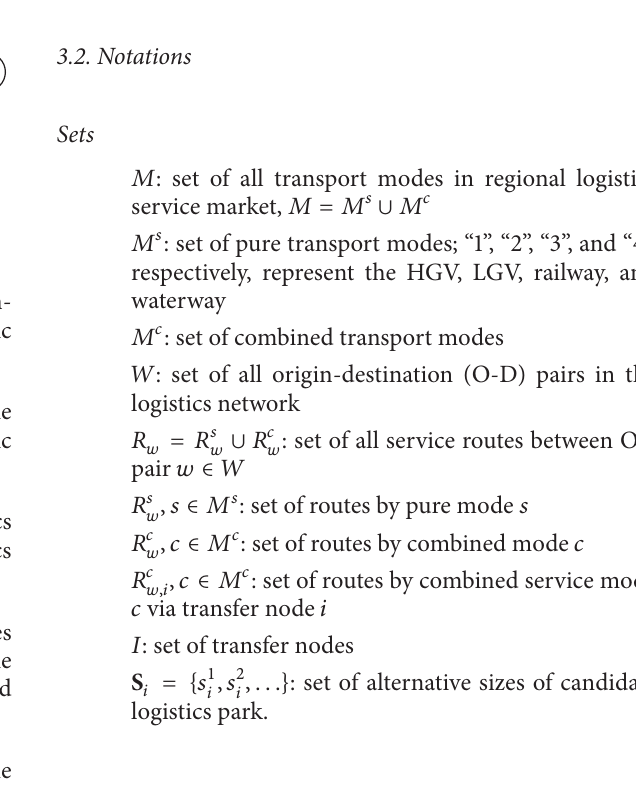
Figure 3: Representation of virtual transfer